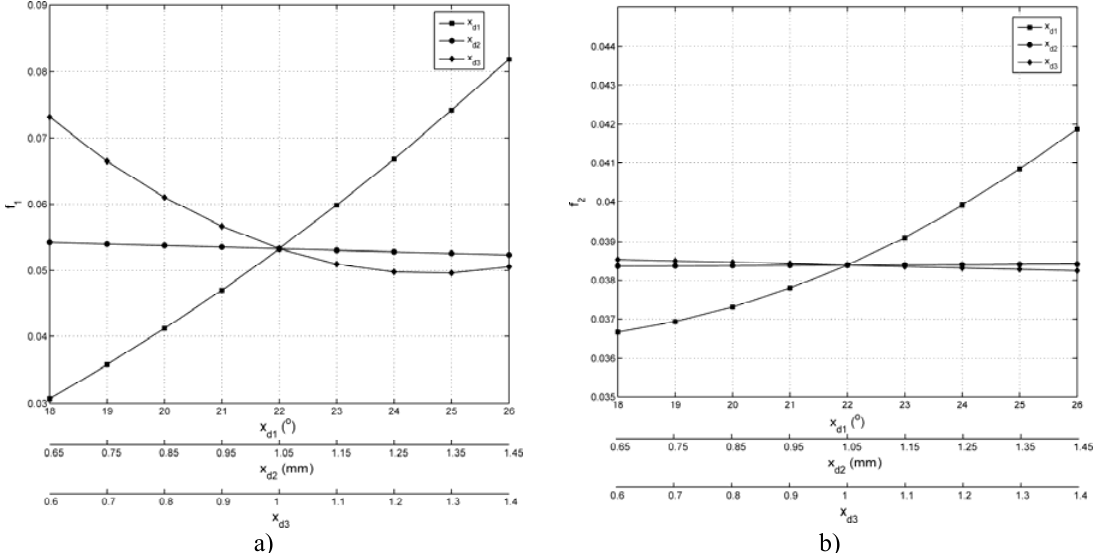
Fig. 5. Main effects of the tire design parameters on the strain energy density at: a) belt edge, b)